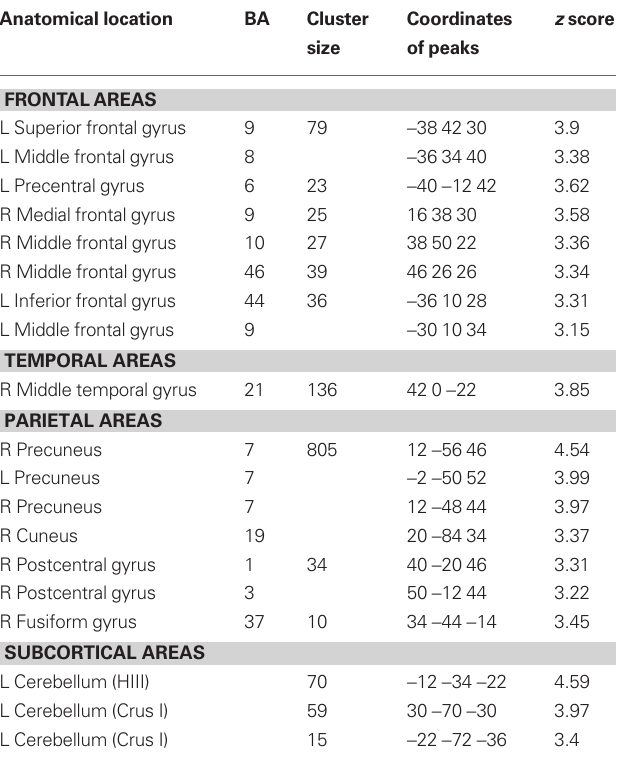
Table 3 | Regions in which older adults exhibit more fMRI task-related activation than young adults within the right sensorimotor cortex ROI (uncorrected p = 0.005).